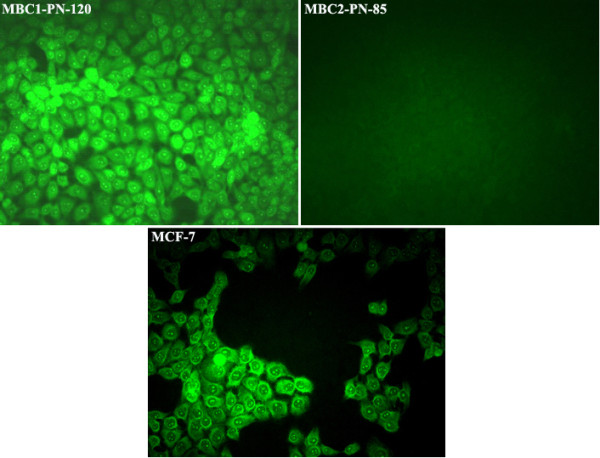
Expression of PR in MBC1 and MBC2 Cell Lines, with MCF-7 as a Positive Control. ICC/IF showed the expression of PR receptor with a localised nuclear staining pattern in the MBC1-PN-120 and MCF-7(as a positive control) but not in MBC2-PN-85. Magnification, 20X.